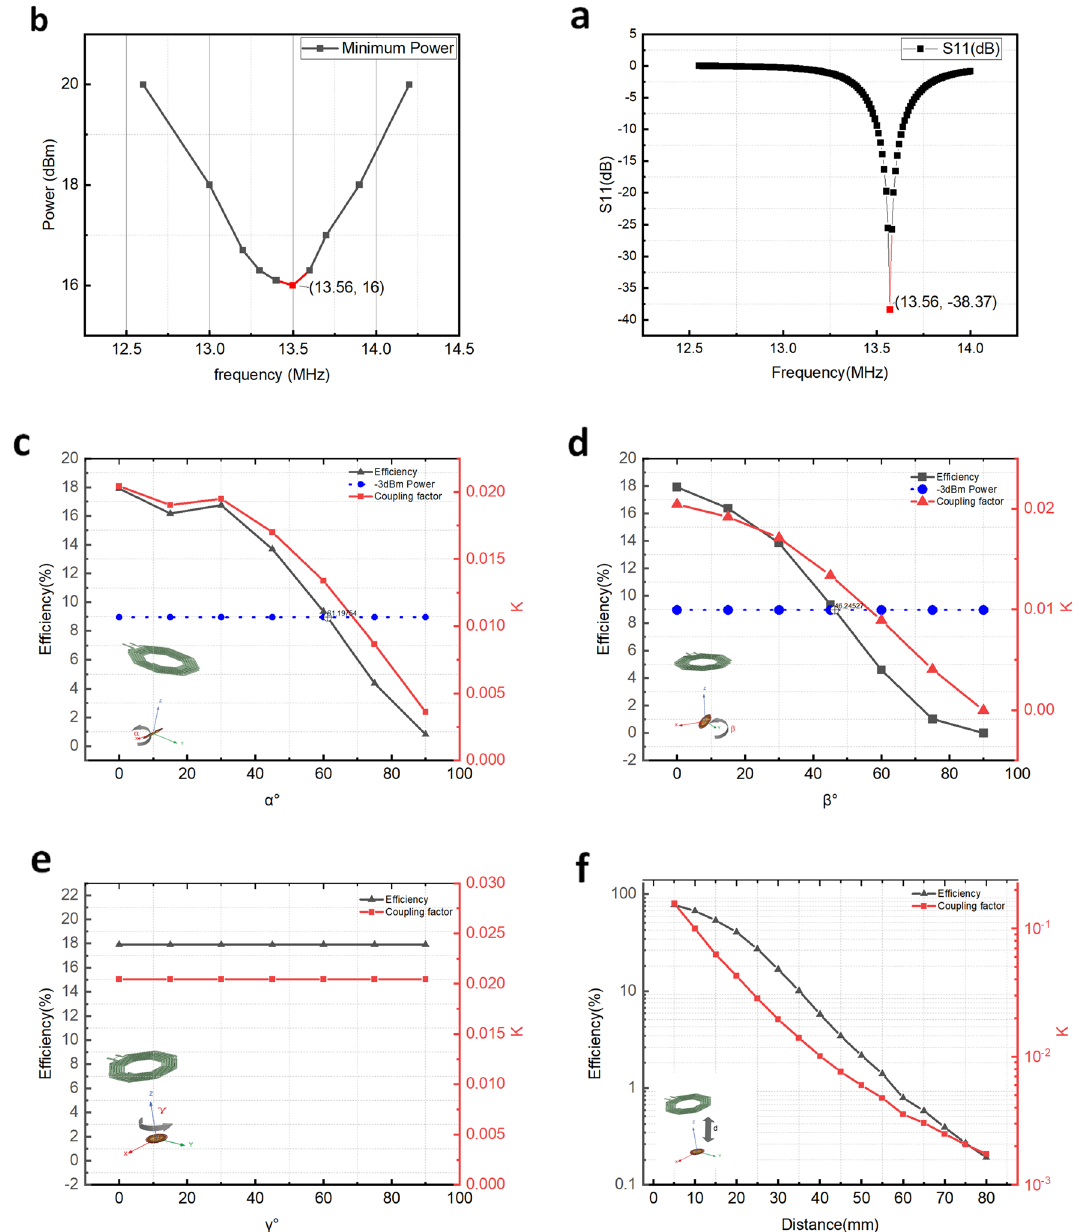
Figure 3. Inductive power transfer design. ( a ) The image shows the minimum required external power to operate the stimulator at a distance of 50 mm. ( b ) Measured S 11 (matching) for the Tx coil, which presents better than 38 dB matching. Simulated efficiency and coupling factor (K) fluctuations in response to variations in the − ( c ) x-axis ( α ), ( d ) y-axis ( β ), ( e ) z-axis ( γ ), and ( f ) distance ( d